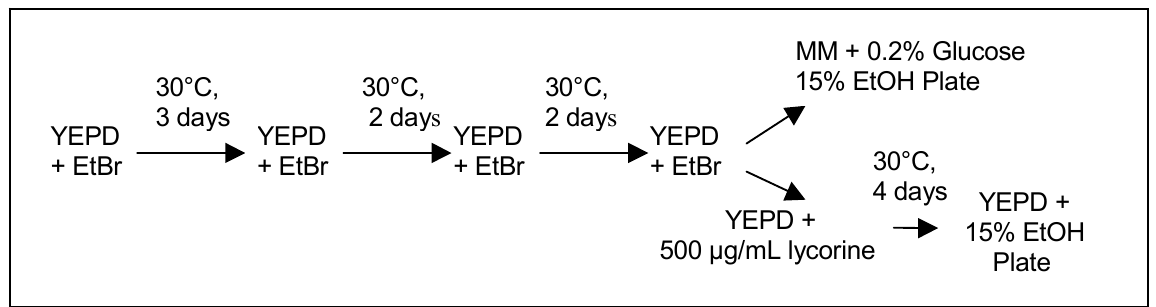
Figure 1. Flow chart of the culture method using ethidium bromide to induce yeast mutation.